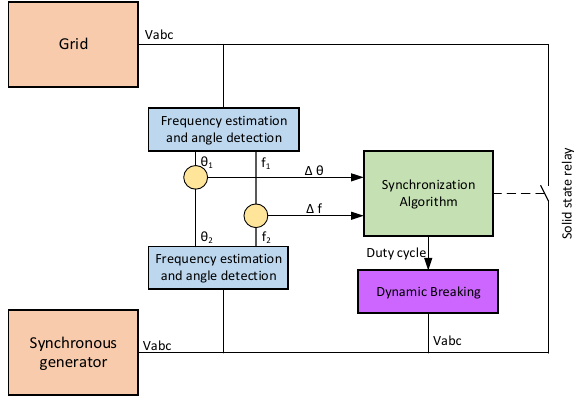
Figure 14. Synchronization controller.